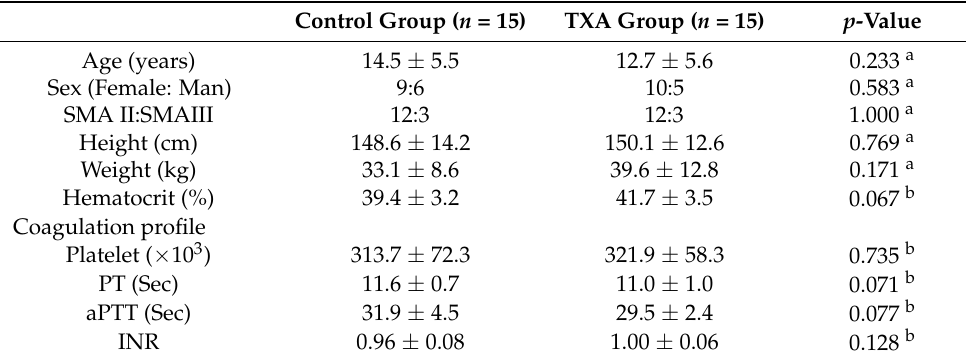
Table 1. Demographic data and surgical